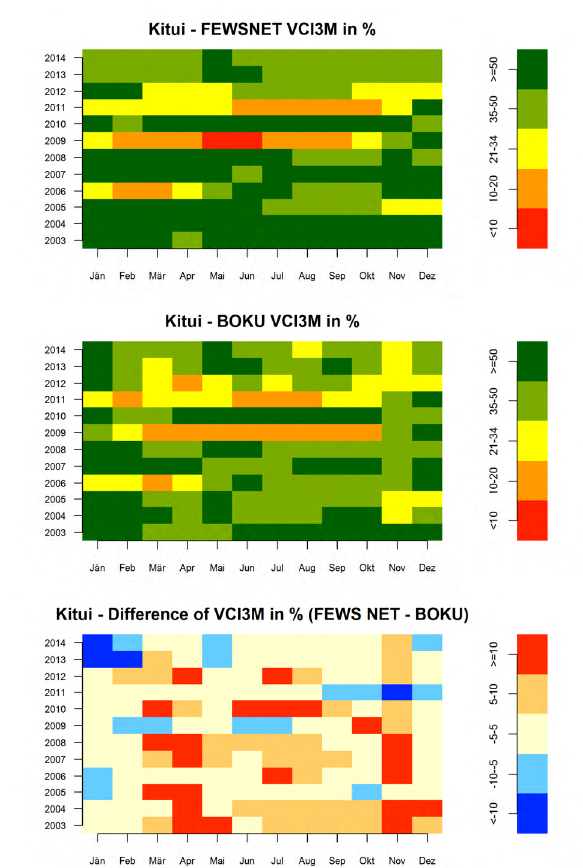
Figure 10: Seasonal matrix plot of categorised monthly VCI3M anomalies for the county of Kitui (2003-2014) derived from (top) FEWS NET dataset, (centre) BOKU dataset and (bottom) difference between both datasets (FEWS NET minus